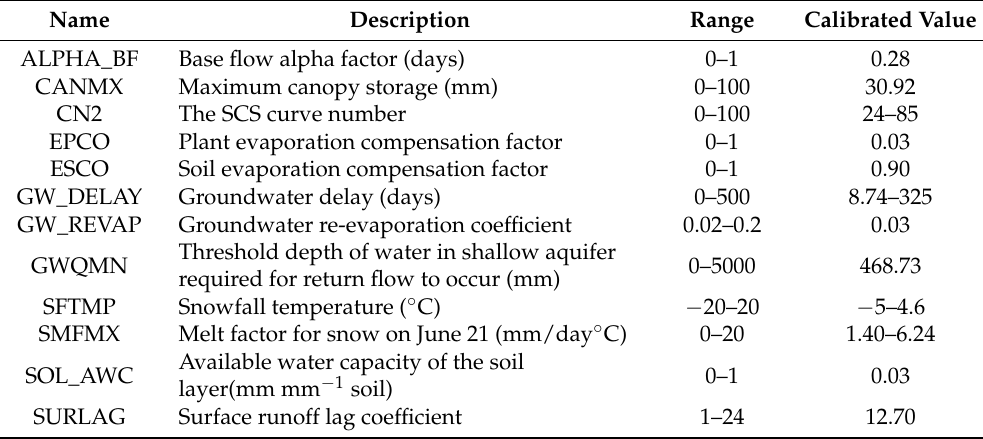
Figure 4. Calibration and validation of the SWAT model. Table 2. Parameters used in the SWAT models.